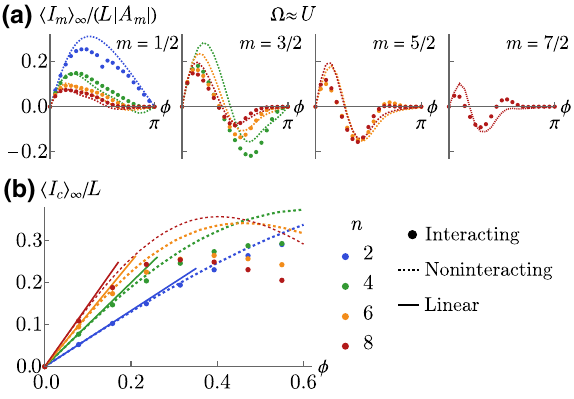
FIG. 7. (a) Average scaled current in different legs m close to the (cid:2) = U resonance for n = 2, 4, 6, 8, fixing U / J = 30 and (cid:2)/ J = 33. The dots show the numerically computed data for the strongly interacting system, sizes L = 9, 5, 4, 4 as before, evolved to time tJ = 500. The dashed line is the corresponding average for a noninteracting system U = 0 with the same initial condition and effective drive strength (cid:2)/ J = 3, and the same distance from the (cid:2) = U resonance assuming that it is shifted from (cid:2) = U to (cid:2) = 0. (b) Average chiral current for the same resonance in the φ (cid:20) 1 limit. The solid lines are a linear approximation with a slope given by Eq. (30).